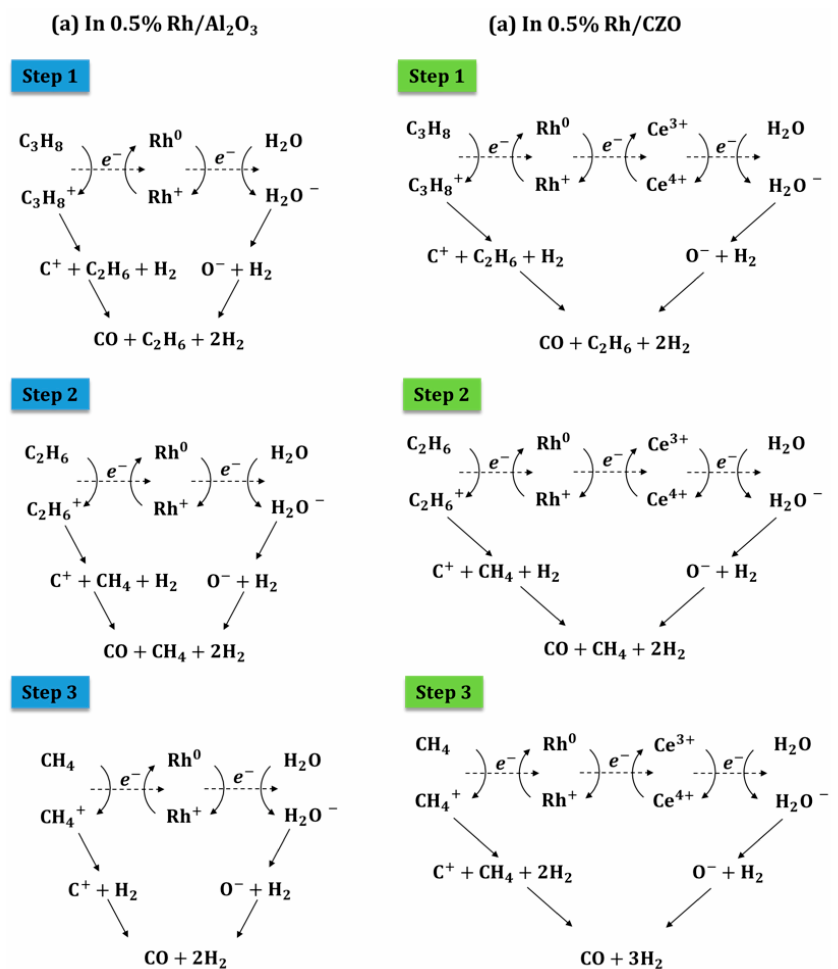
Figure 14. Proposed reaction mechanism and electron transfer pathways for